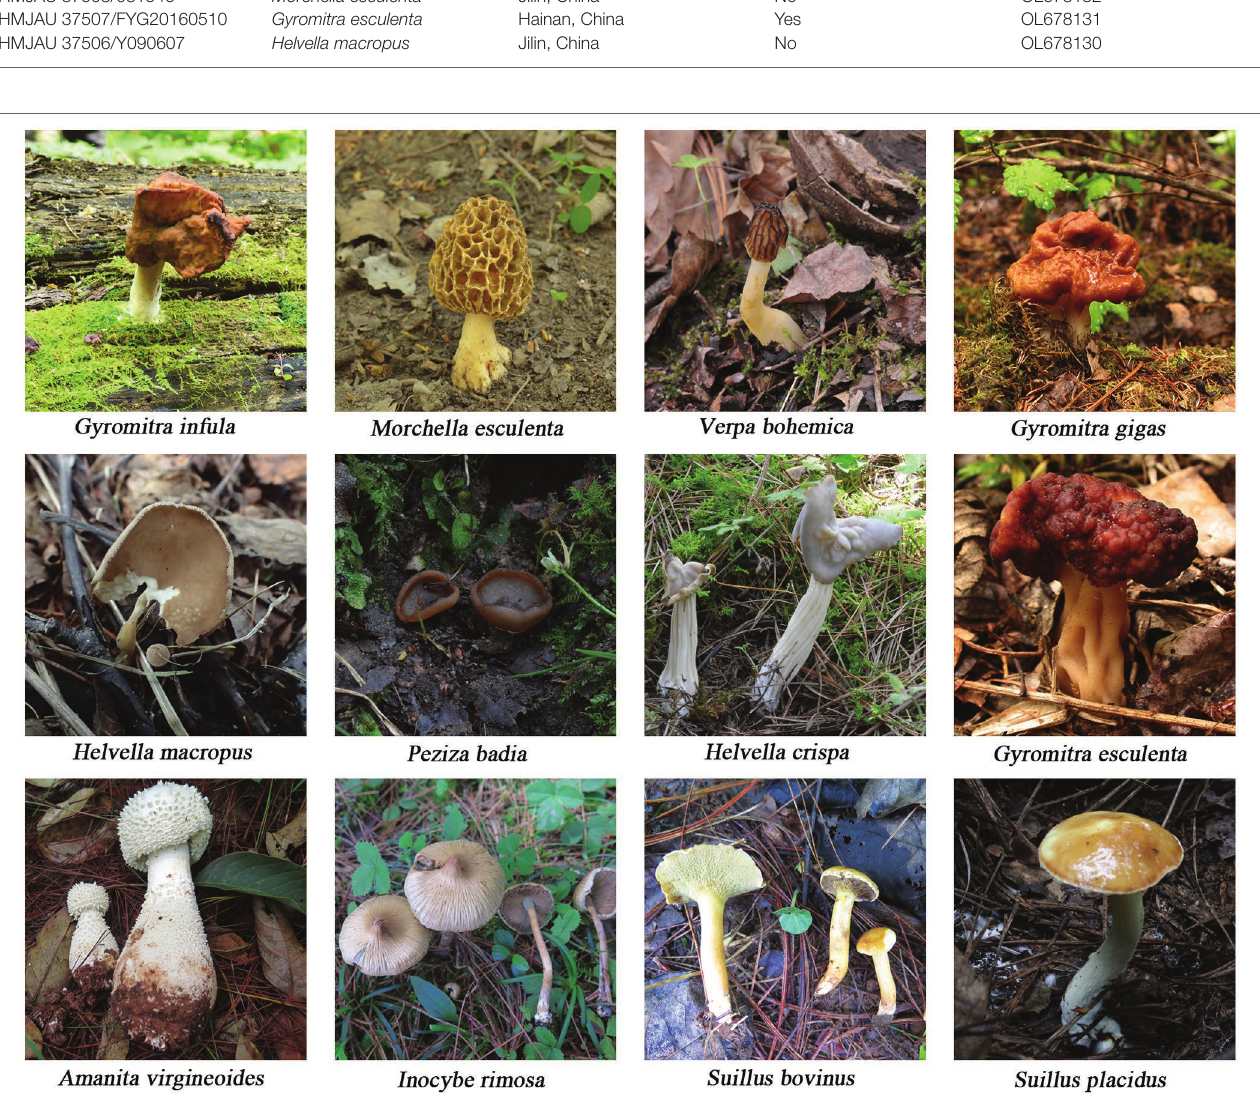
FIGURE 1 | Photographs of mushroom species collected in this study. Photos by Yuguang Fan, Enjing Tian, and Qianqi